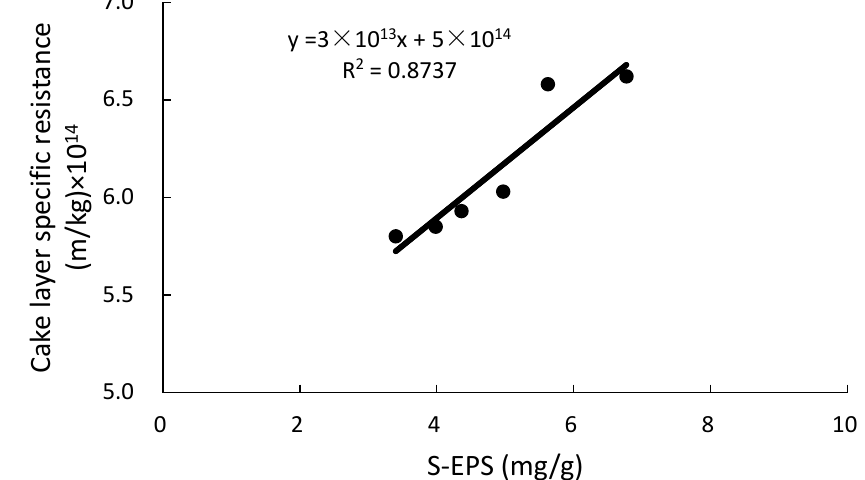
Figure 5. Relationship between soluble extracellular polymeric substances (S-EPS) and cake layer specific resistance.